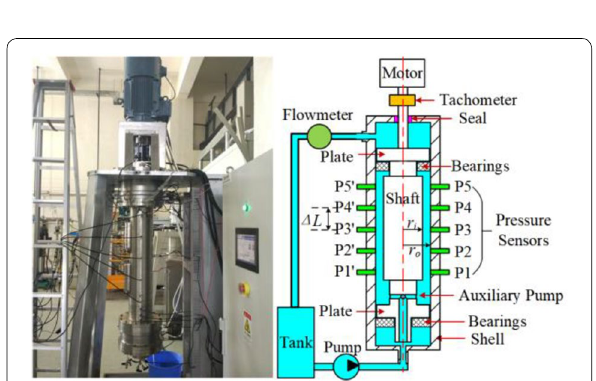
Figure 5 Experimental equipment and